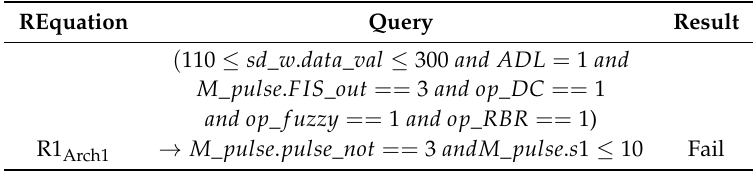
Table 2. UPPAAL analysis: A case where real-time constraints are not